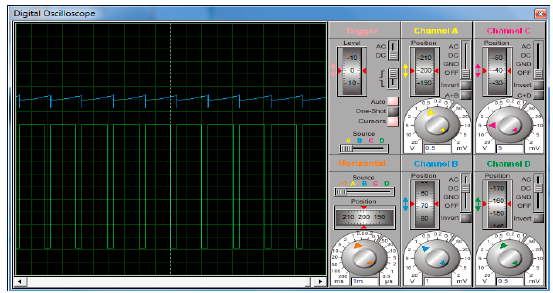
Figure 10. Switching wave of simulation from virtual oscilloscope.